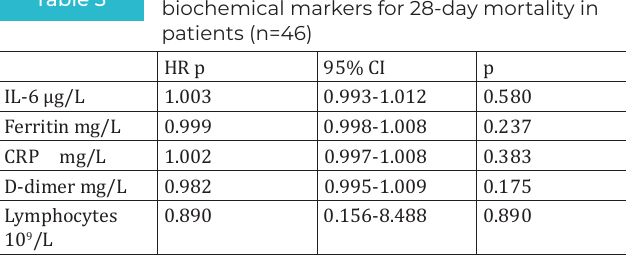
Cox proportional hazards model for Table 3 biochemical markers for 28-day mortality